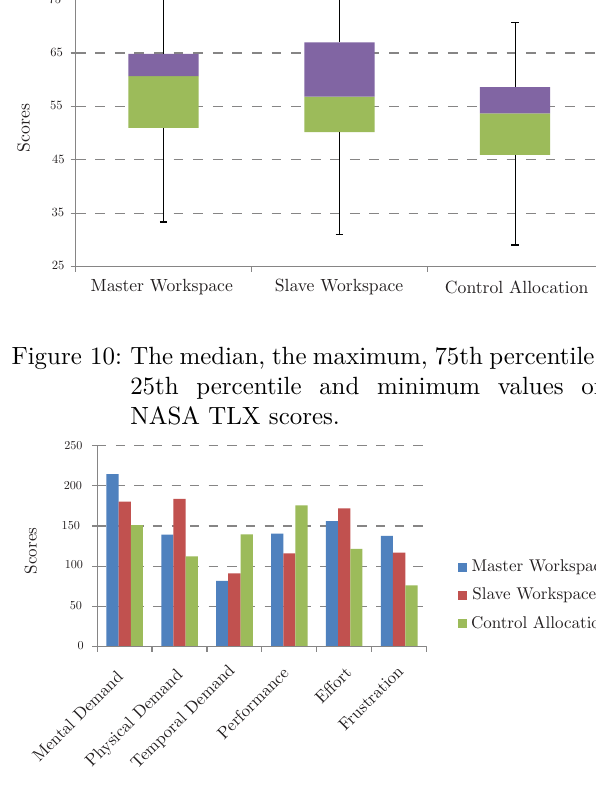
Figure 9: The median, the maximum, 75th percentile, 25th percentile and minimum values of manipulability.